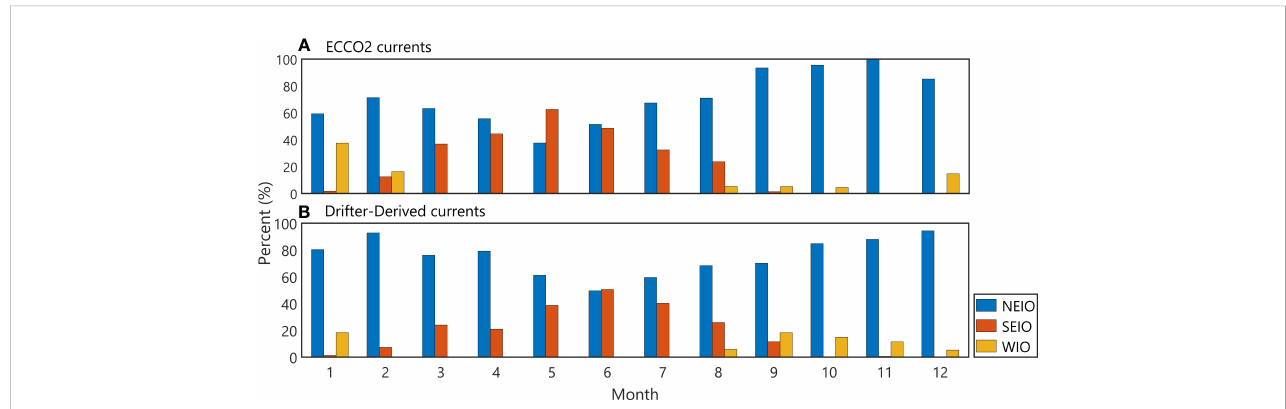
FIGURE 5 Percentage distributions of particles in the three regions (in Figure 3A) released in different months based on the (A) ECCO2 and the (B) drifter-derived currents.